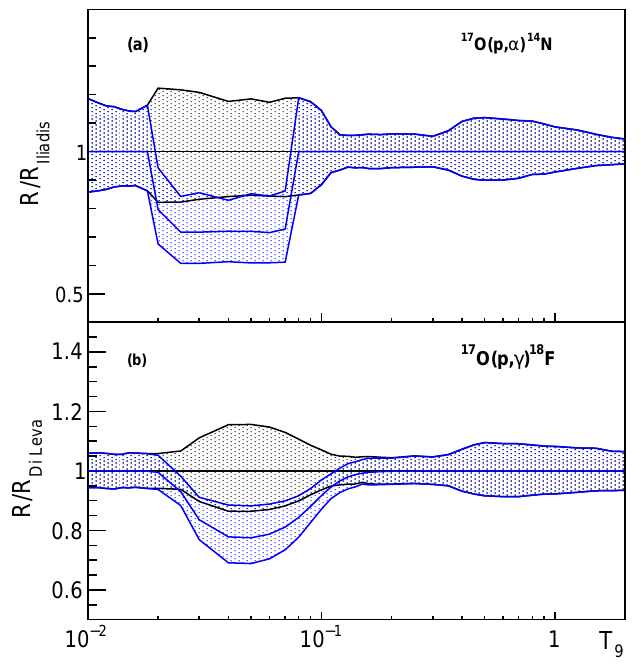
Figure 3. ( a ) Comparison of the THM reaction rate (blue lines) of the 17 O(p, α ) 14 N reaction with the direct one [73] (black lines). ( b ) Comparison of the THM reaction rate (blue lines) of the 17 O(p, γ ) 18 F reaction with the direct one [78] (black